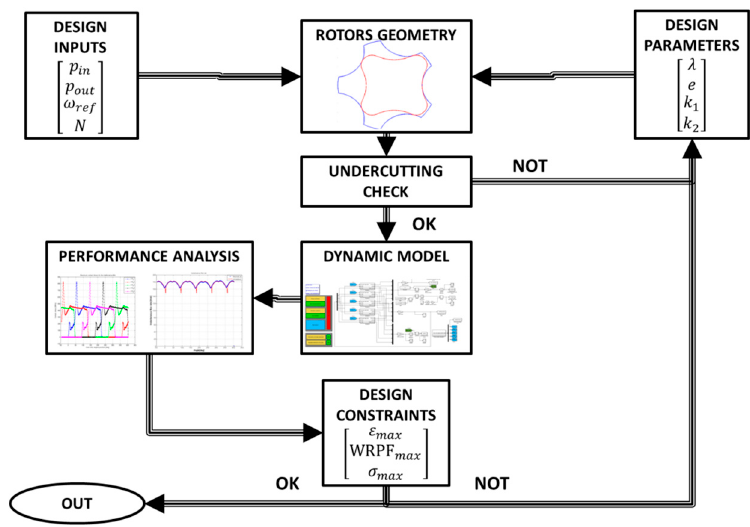
Figure 12. Design framework flowchart.